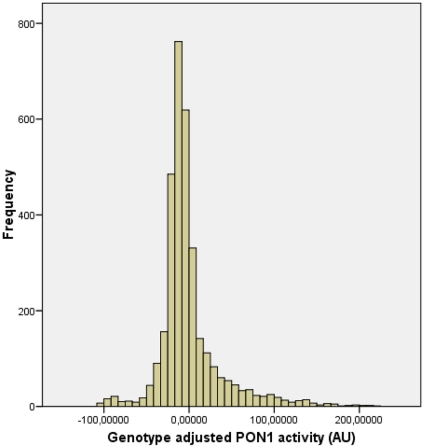
Histogram showing the normal distribution of PON1-activity after adjusting for the PON1-Q192R polymorphism.